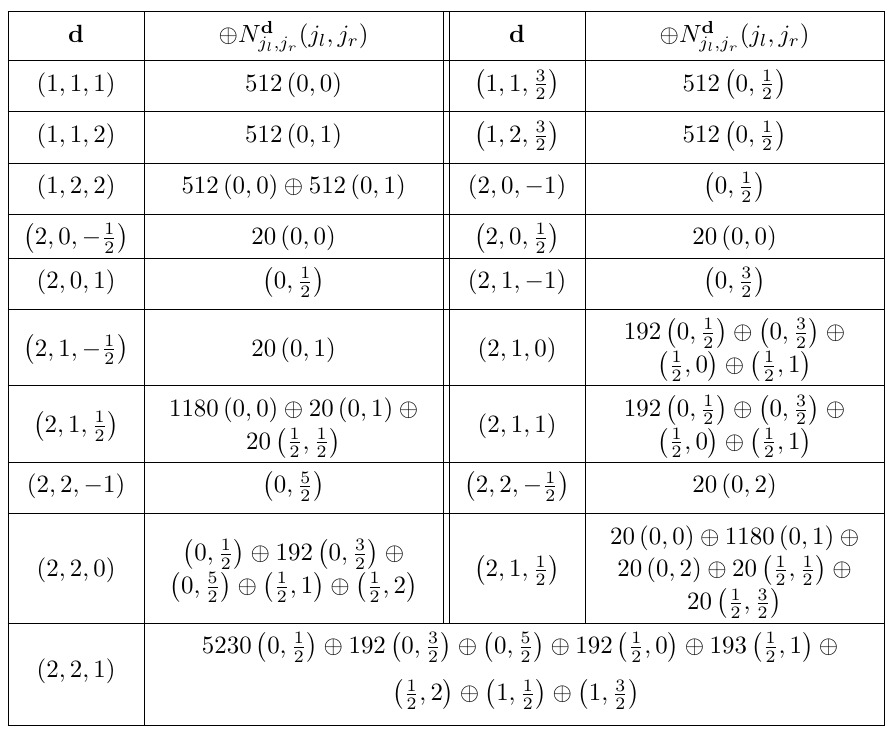
Table 18. BPS spectrum of the Sp(2)+10 F theory for d 1 = 1 , d 2 , d 3 ≤ 2 and d 1 = 2 , d 2 ≤ 2 , d 3 ≤ 1 . Here, d = ( d 1 , d 2 , d 3 ) labels BPS states with charge d 1 m 0 + d 2 α 1 + d 3 α 2 , where α 1 = 2 φ 1 − φ 2 , α 2 = − 2 φ 1 + 2 φ 2 are the simple roots of sp (2) algebra, and 10 flavor charges are blindly summed